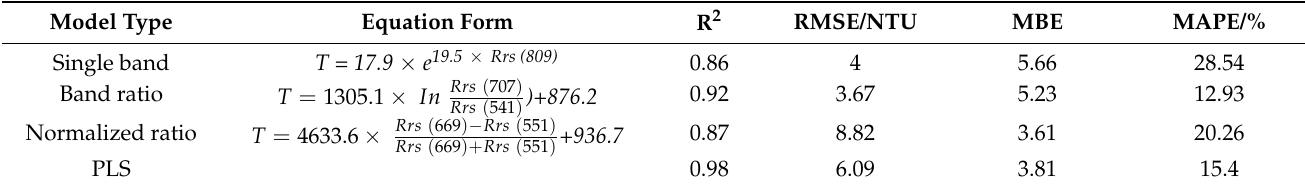
Table 3. Hyperspectral imager model and modeling